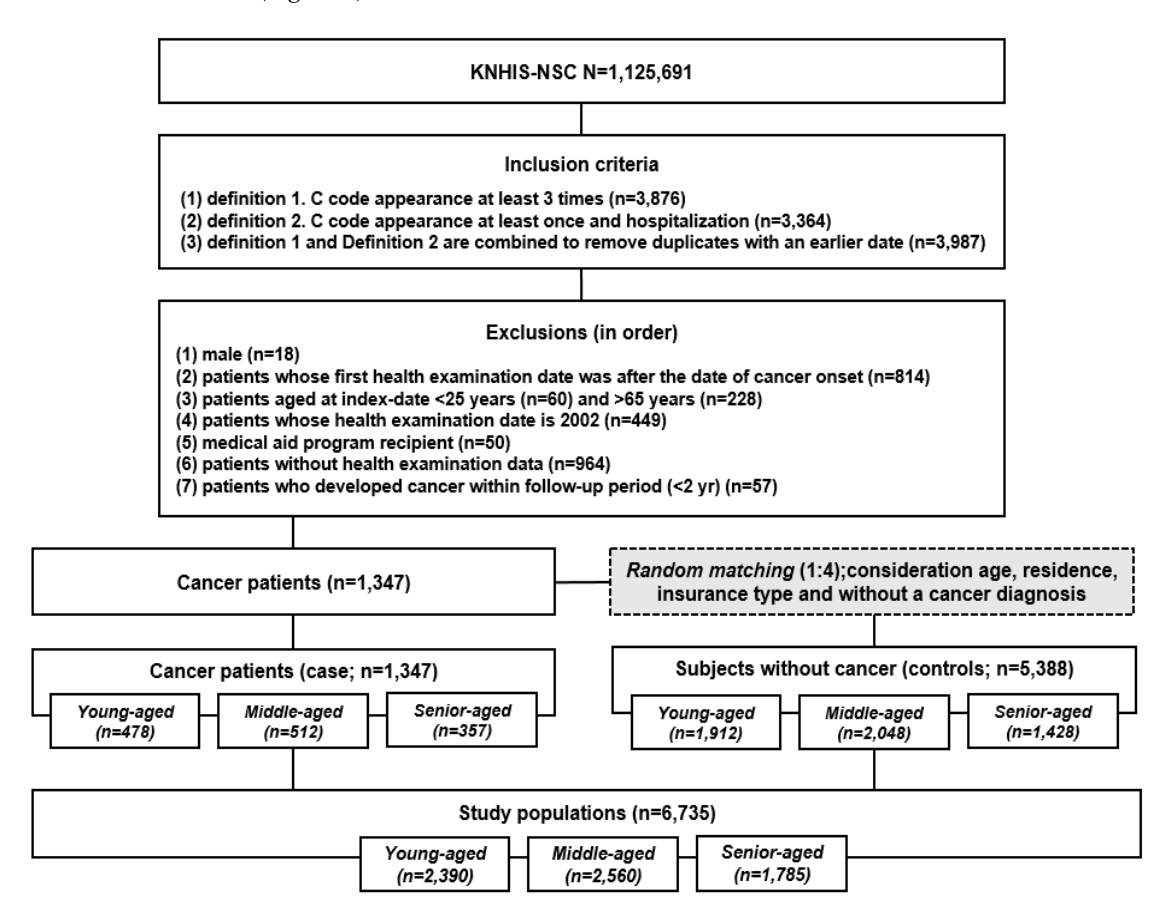
Figure 2. Flow diagram of study population selection .